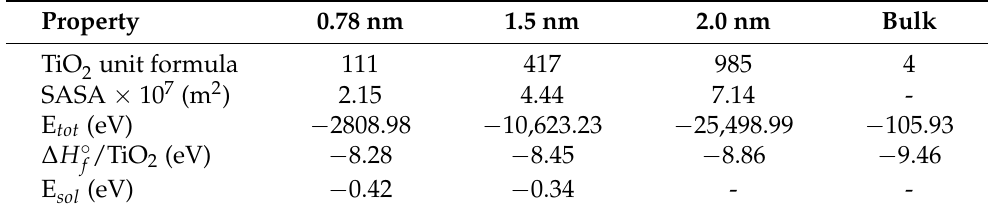
Table 1. Selected physico-chemical properties for the three molecular models. SASA is the solvent- accessible surface area, E tot is the total energy in eV, ∆ H ◦ (experimental value for bulk anatase is − 9.78 eV [54]), E sol is the solvation energy [32] in eV (not available for the largest